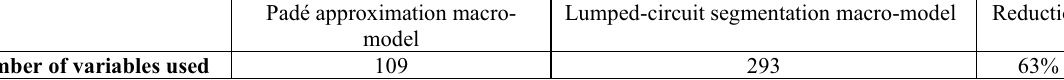
Table 2. Comparison between the lumped-circuit segmentation macro-model and the Pade Approximation Padé approximation macro-